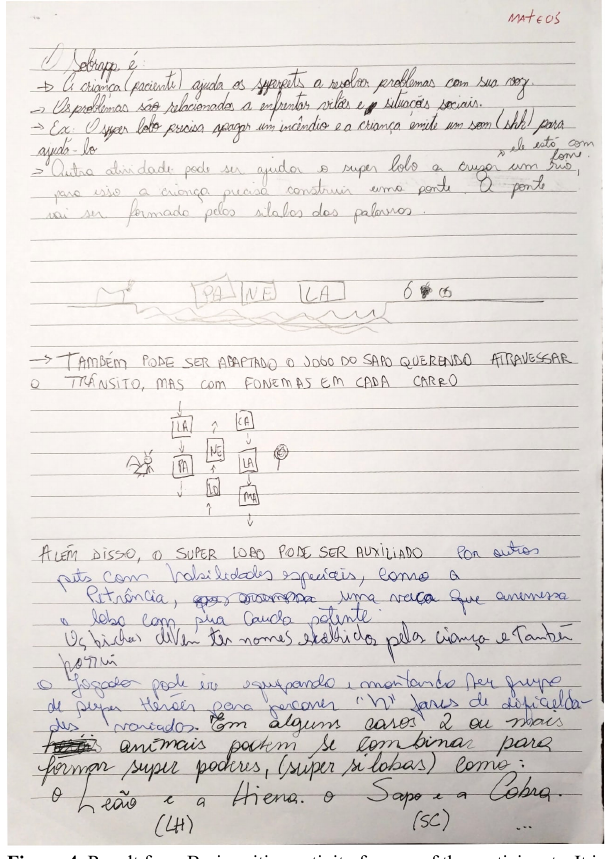
Figure 4. Result from Brainwriting activity for one of the participants. It is possible to see the different ideas from each